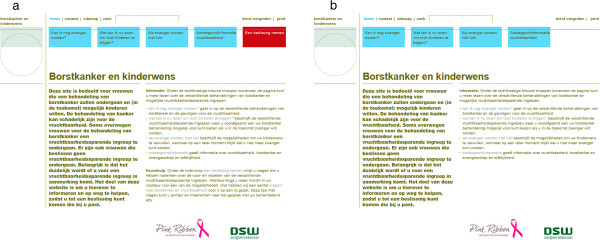
The two types of DAs: a) DA with information (blue buttons) and the VCE (red button); b) DA with information only (blue buttons).